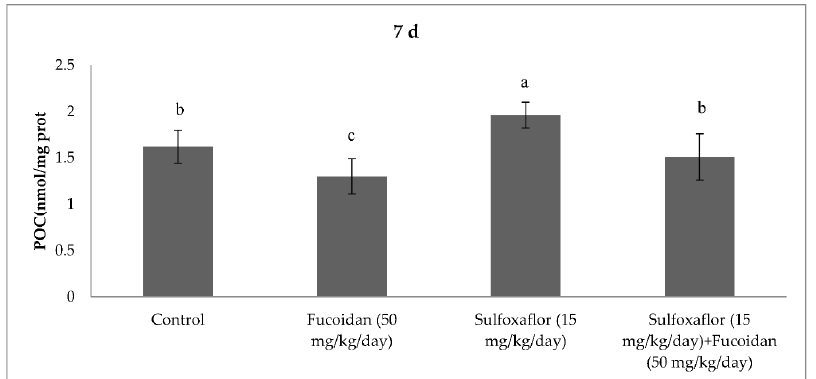
Figure 6. Effects of Sulfoxaflor and Fucoidan on POC Levels (nmol/mg protein) in Serum of Mice at 7-d Treatment Periods. Values are expressed as mean ± standard error. POC: Protein carbonyl. Letters a, b and c show the differences between treatment groups and control. Data shown in different letters are significantly different at p < 0.05 level ( n = 8). Duncan multiple comparison tests were used.